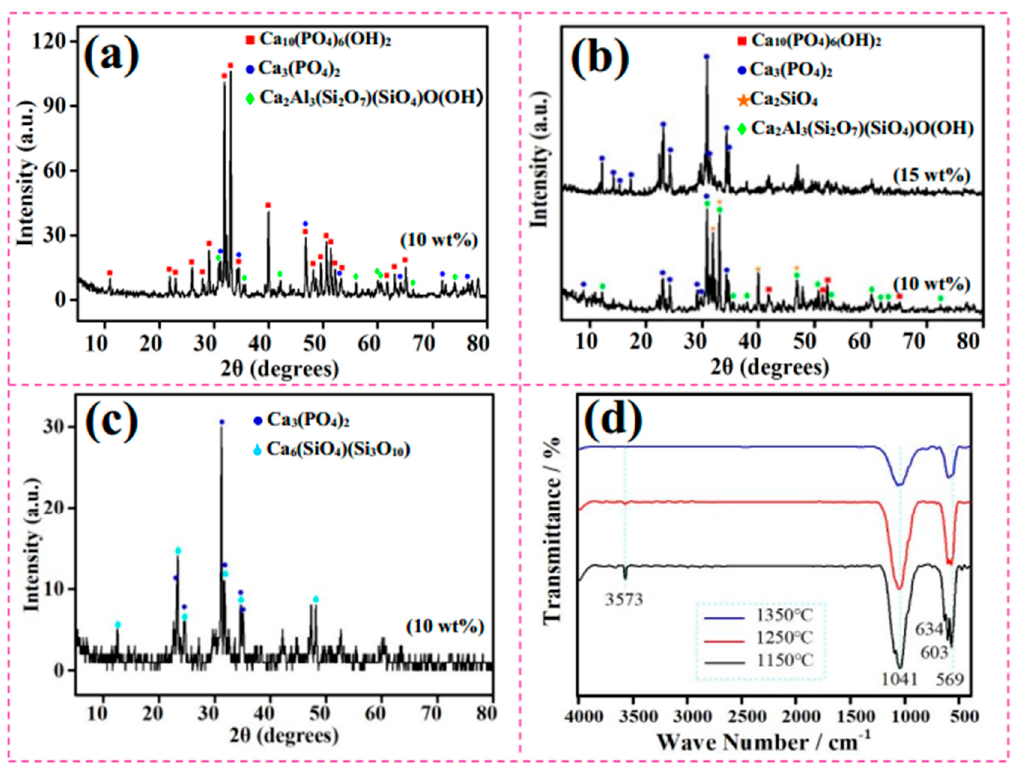
Figure 5. XRD spectra of MF/HA composites sintered at: ( a ) 1150 °C—10 wt%; ( b ) 1250 °C—10/15 wt%; ( c ) 1350 °C—10 wt%; and ( d ) Fourier transform infrared (FTIR) spectra of the composites with the addition of 10 wt% MF.